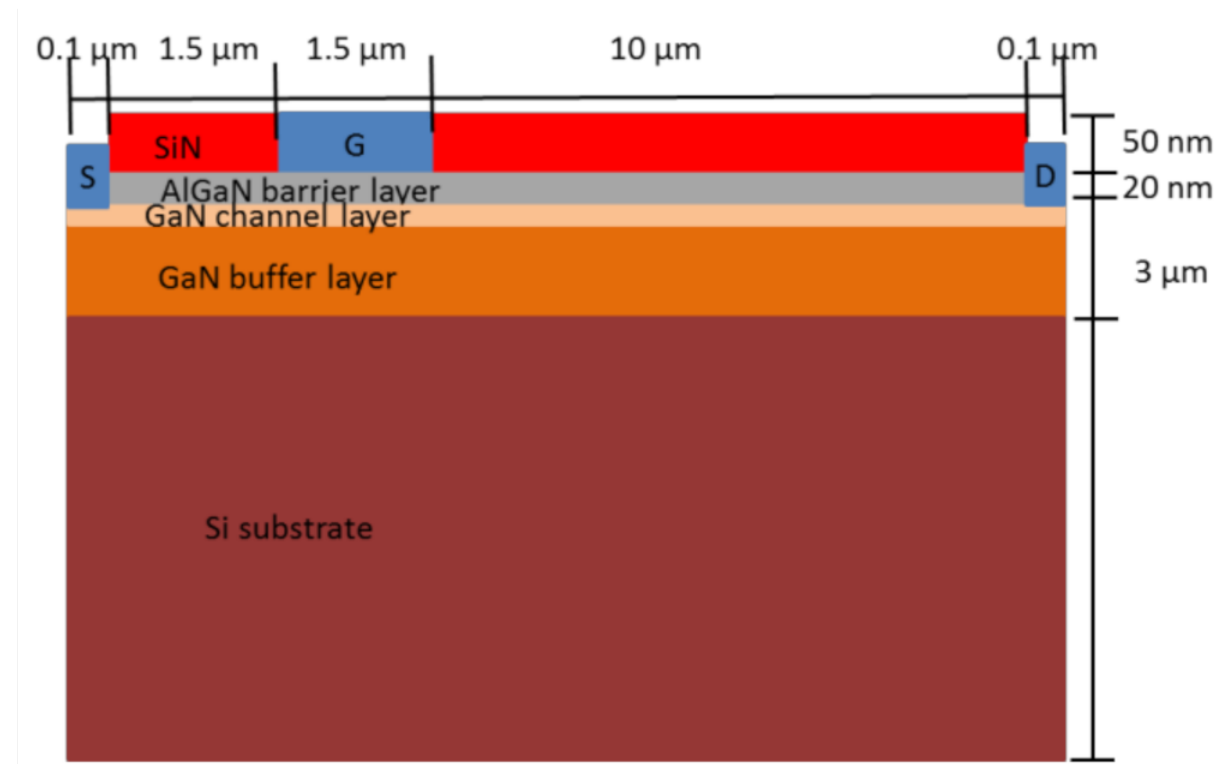
Figure 2. The schematic of the depletion-mode AlGaN/GaN